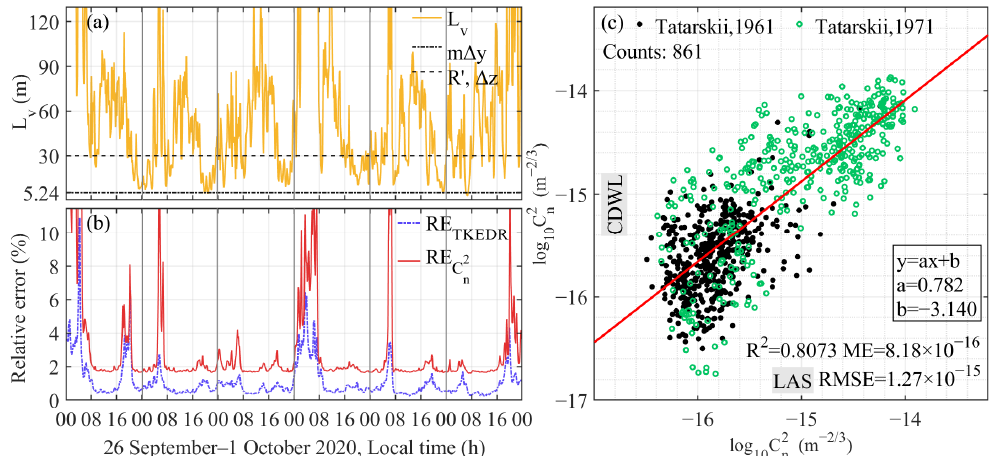
Figure 3. The integral scale (cid:1838) (cid:3049) ( a ), relative error of the estimation of TKEDR and (cid:1829) (cid:3041)(cid:2870) ( b ), and comparative statistical analysis of LAS and CDWL observation results ( c ) from 26 September to 1 October 2020, local time.